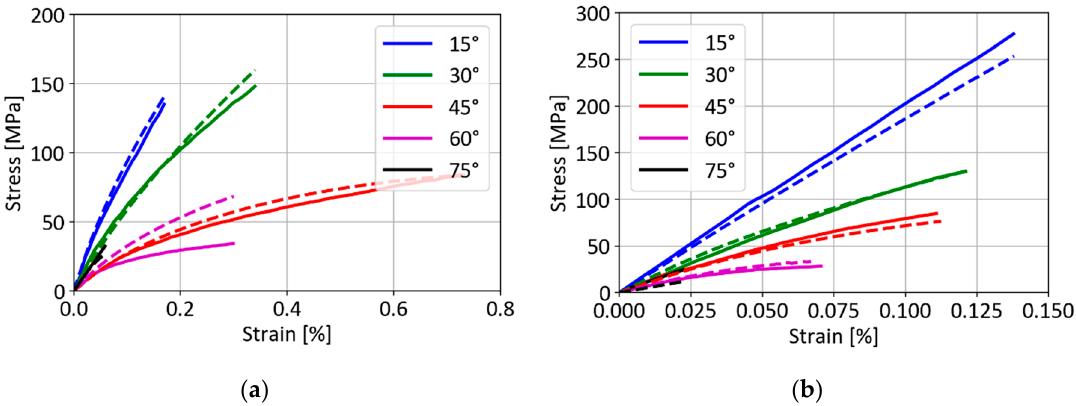
Figure 4. Comparison between stress–strain curves obtained from simulation (broken line) and tensile